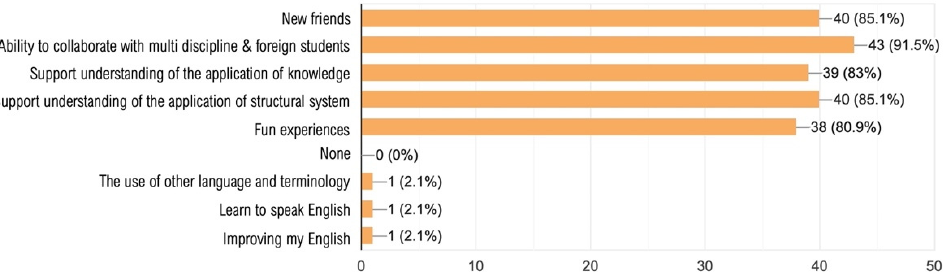
Figure 9. Benefits from joint studio assignment.